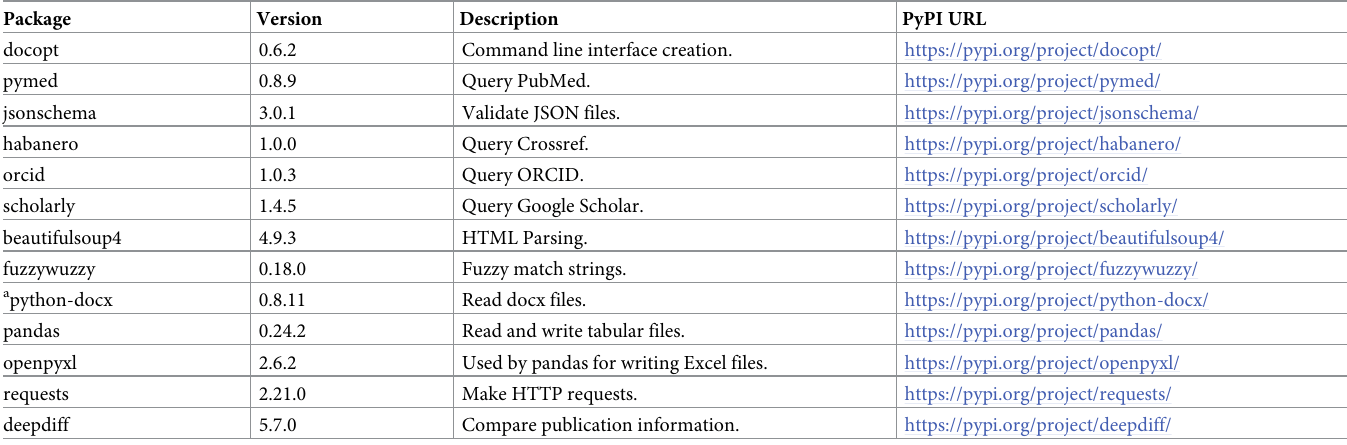
Table 1. Library dependencies for Academic